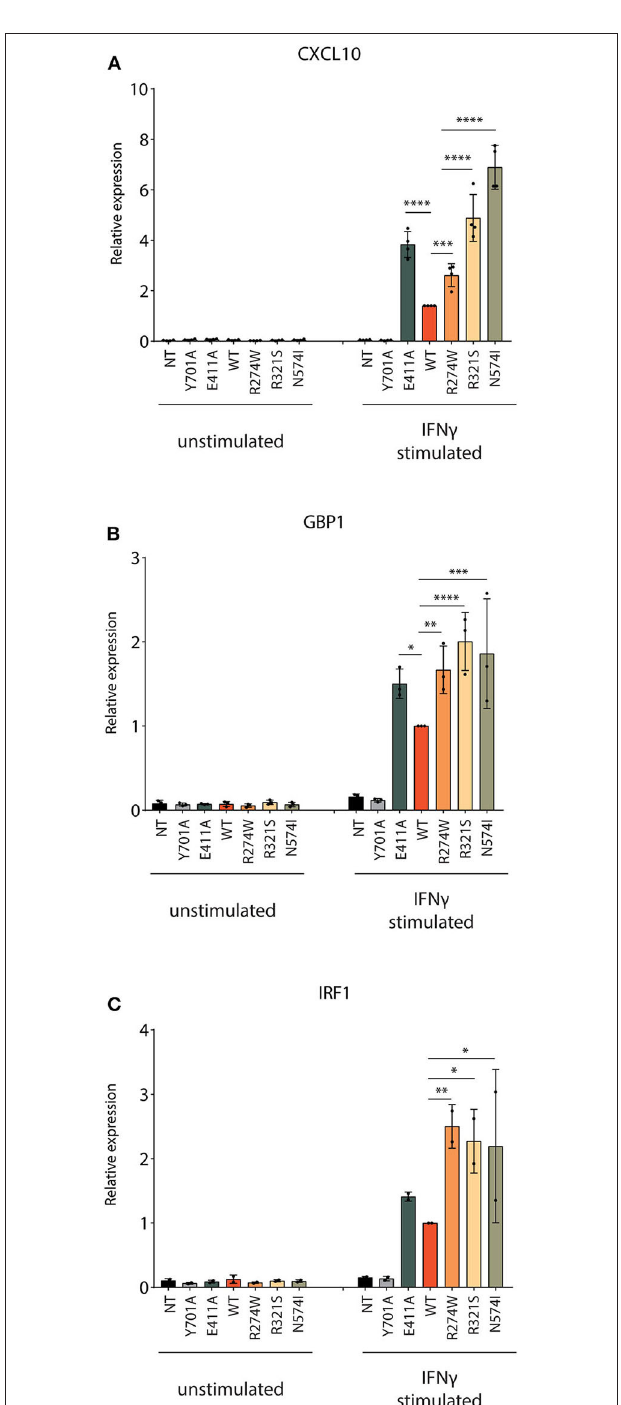
FIGURE 3 | Quantification of ISGs expression level. The mRNA expression level of three ISGs (A) CXCL10, (B) GBP1 and (C) IRF1 was measured before and after 4h stimulation with IFN γ (1 U/ µ l). Expression levels were normalized for housekeeping PSIP1 mRNA expression and plotted as fold increase compared to IFN γ stimulated STAT1 WT condition for each experiment. The experiment was independently repeated 2–4 times for each gene and pooled data are presented. Data are represented in bar graphs as mean ± standard deviation. Statistical analysis: One-way ANOVA with Tukey’s post-hoc test. * P < 0.05 ; ** P < 0.01 ; *** P < 0.001 ; **** P <